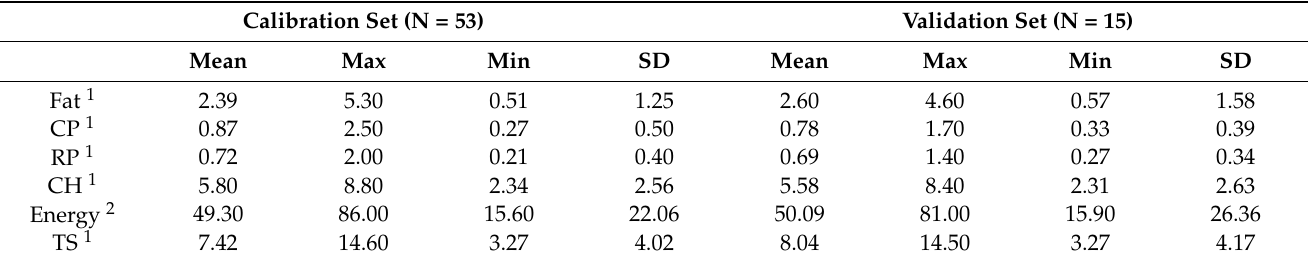
Table 1. Statistics of macronutrients and energy in breast milk (N =